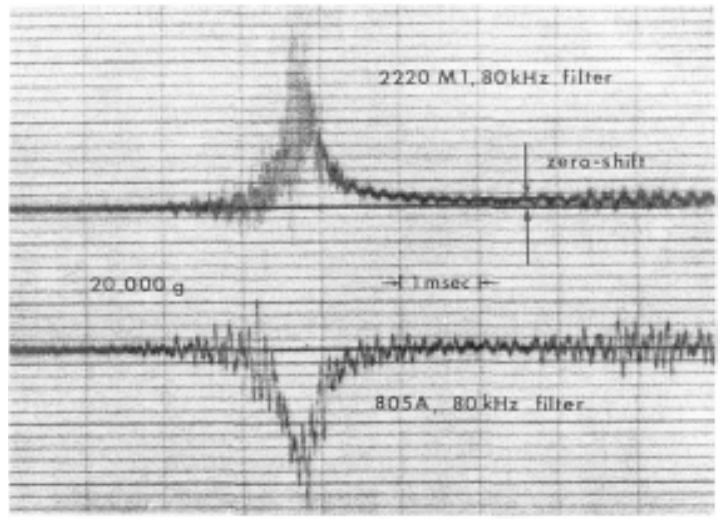
Fig. 9. Comparison of response of Kistler 805A with ferroelectric ceramic